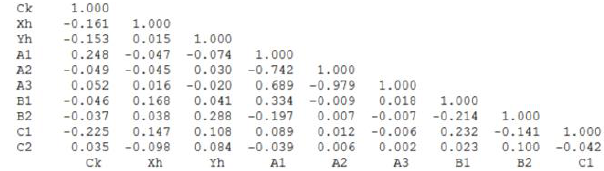
Table 2: Correlations of the parameters of the calibrated interior orientations.